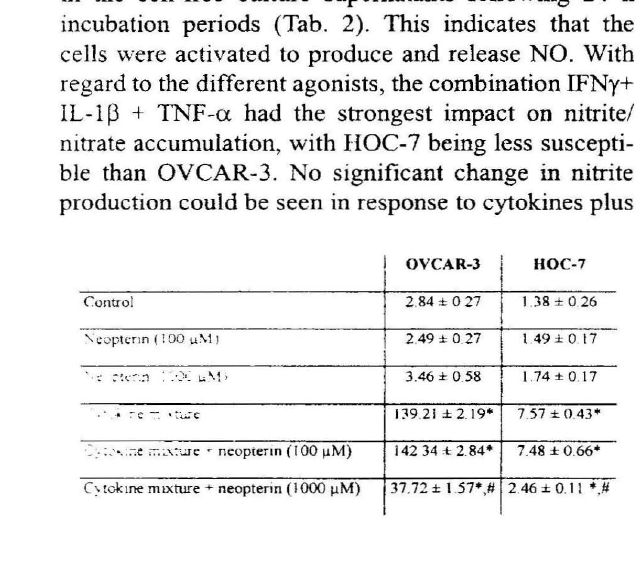
Table 2. Nitrite/nitrate concentrations determined as accumulated nitrite (nmoJ! 106 cells) in the cell-free culture supernatants of ovarian carcinoma cells fol lowing 24 h incubations. Data are expressed as mean ± SEM, n=8 .... P<O.05 as compared to unstimulated controls, # P<O.05 as com pared to incubations with the cytokine mixture. Cytokine mixture = interferon-g (100 U/ml) + inter leukin-lB (10 U/ml) + tumor necrosis factor-a (500 U/ml).